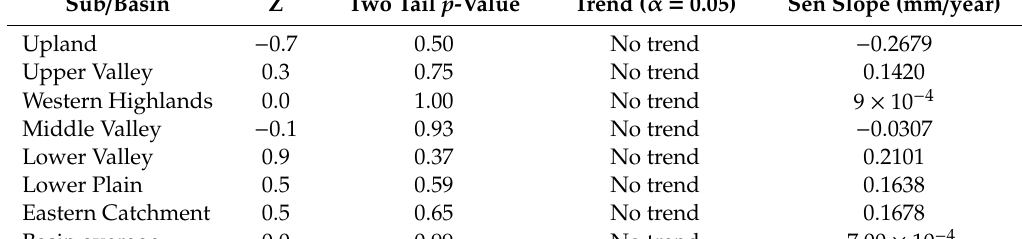
Figure 6. The ACF plots for annual ( a ) and seasonal rainfall ( b – d ) time series for the entire basin. Table 3. Summary trend analysis for annual rainfall time series.